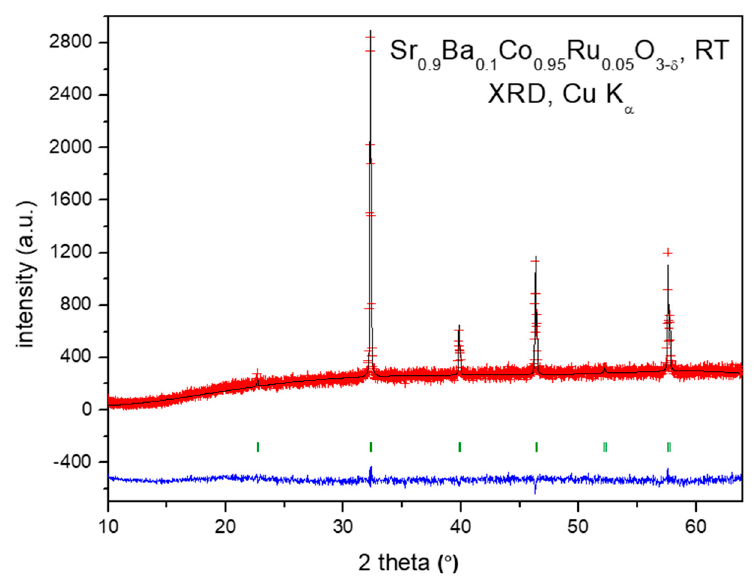
Figure 1. Observed (red crosses) and calculated profiles (full black line) for Sr 0.9 Ba 0.1 Co 0.95 Ru 0.05 O 3 − δ perovskite after Rietveld refinement of the crystal structure in a standard perovskite model in the Pm-3m space group, with unit-cell parameter of a = 3.9159(5) Å. The difference plot (full blue line) and allowed Bragg reflections (green vertical lines) are also shown.